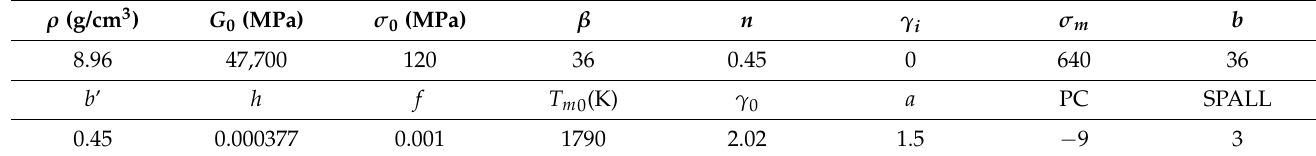
Table 5. Material parameters of the Steinberg–Guinan model for the copper liner.